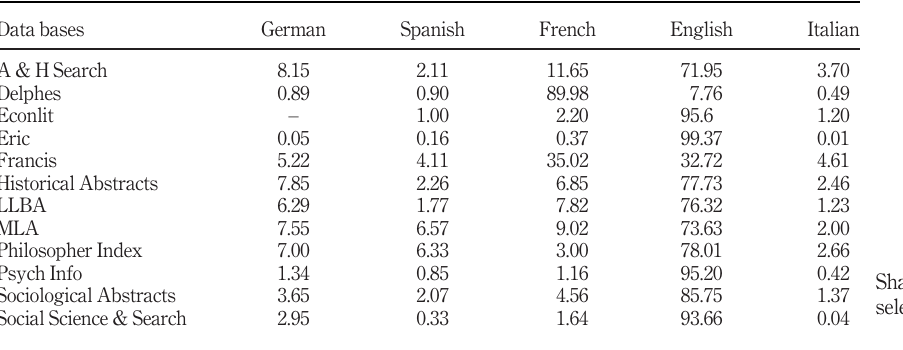
Table II. Share of languages